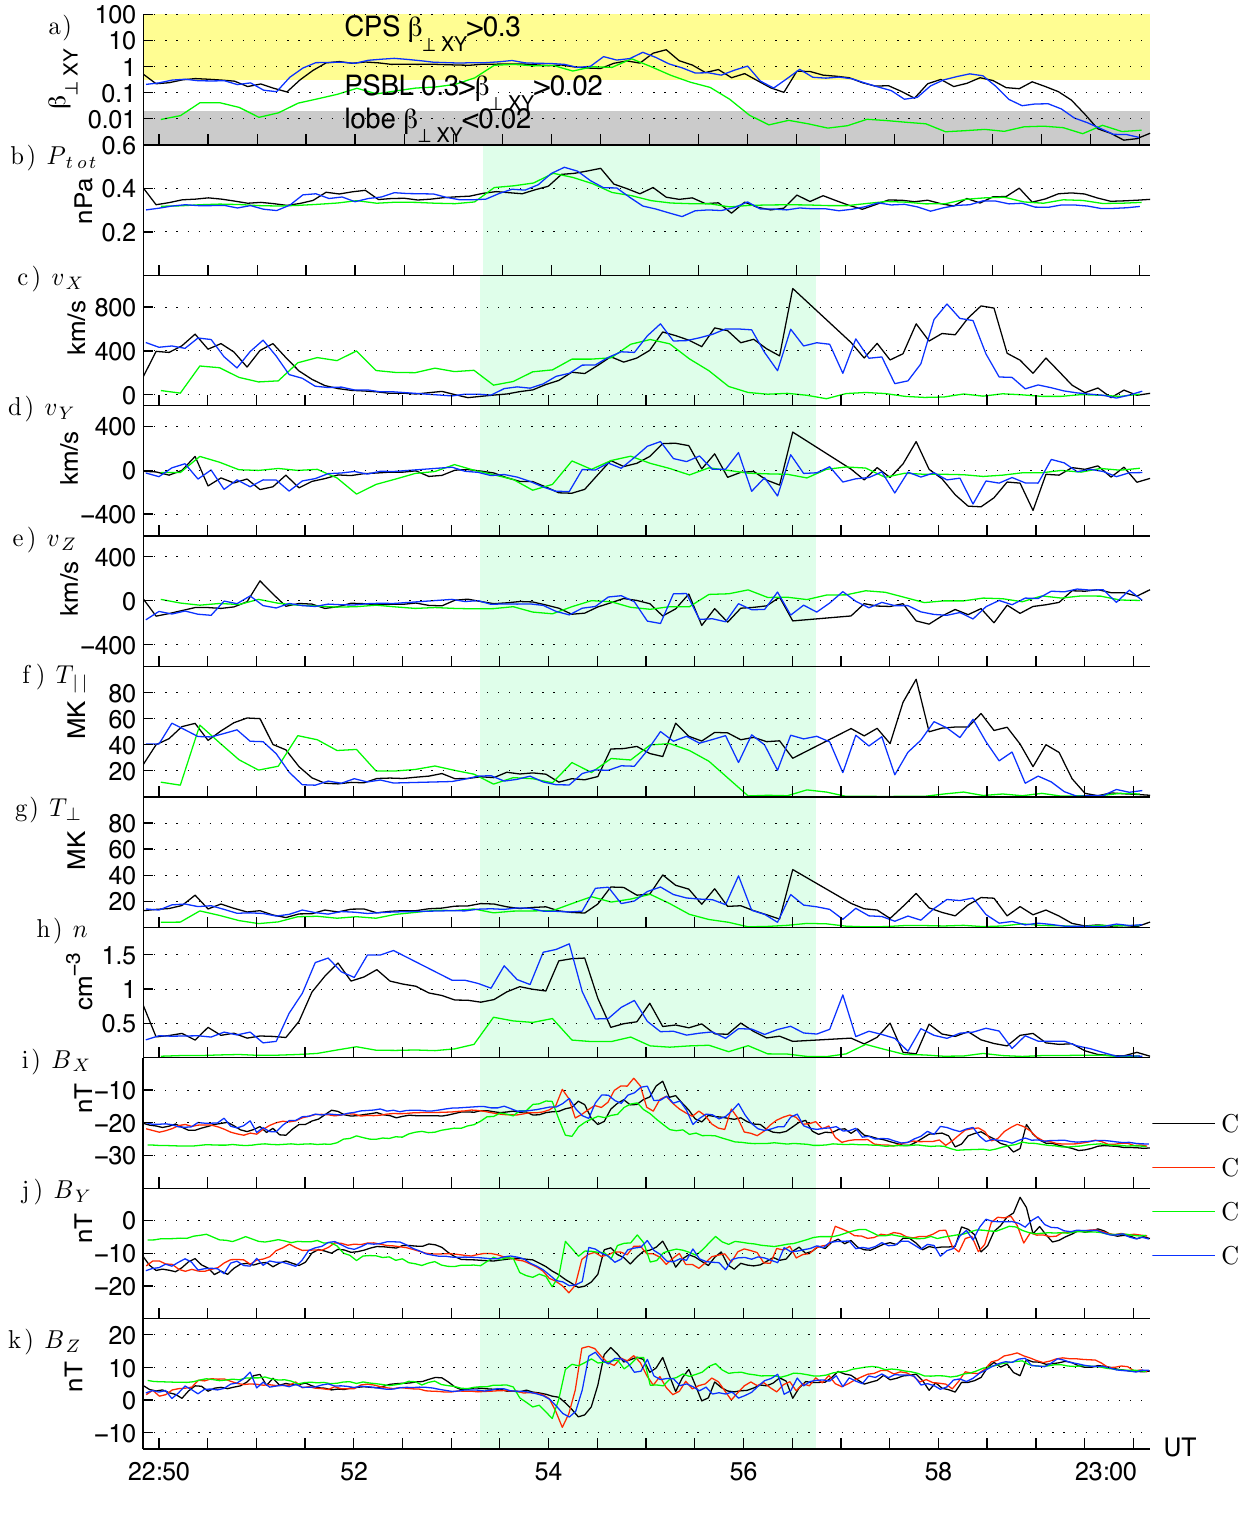
Fig. 2. Overview of key parameters during the event. The panels show: (a) Plasma beta. Background colors indicate regions of the plasma sheet based on results from Baumjohann et al. (1988) and Baumjohann et al. (1989). (b) Total pressure. (c–e) GSM components of the plasma velocity. (f–g) Parallel and perpendicular temperatures. (h) Proton density (C1,C4) and ion density (C3). (i–k) GSM components of the magnetic field. The standard spacecraft color scheme is used. The green shaded interval from 22:53:17 to 22:53:44 indicate the BBF